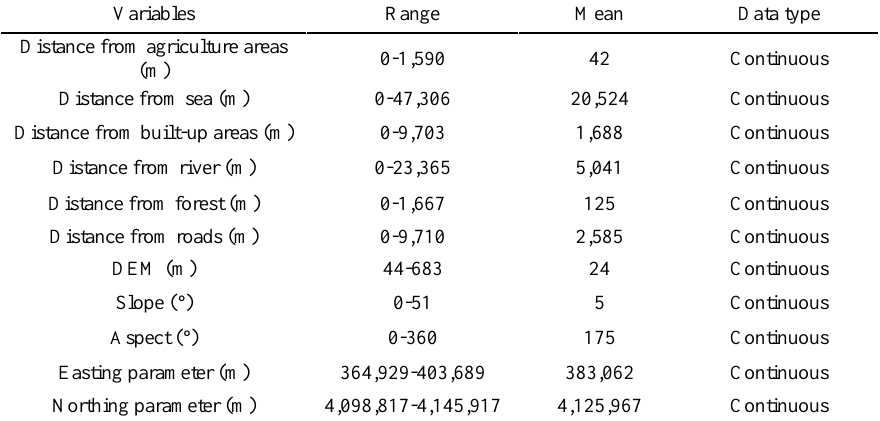
Table 1. Spatial explanatory variables of urban change between 1985 and 2000.